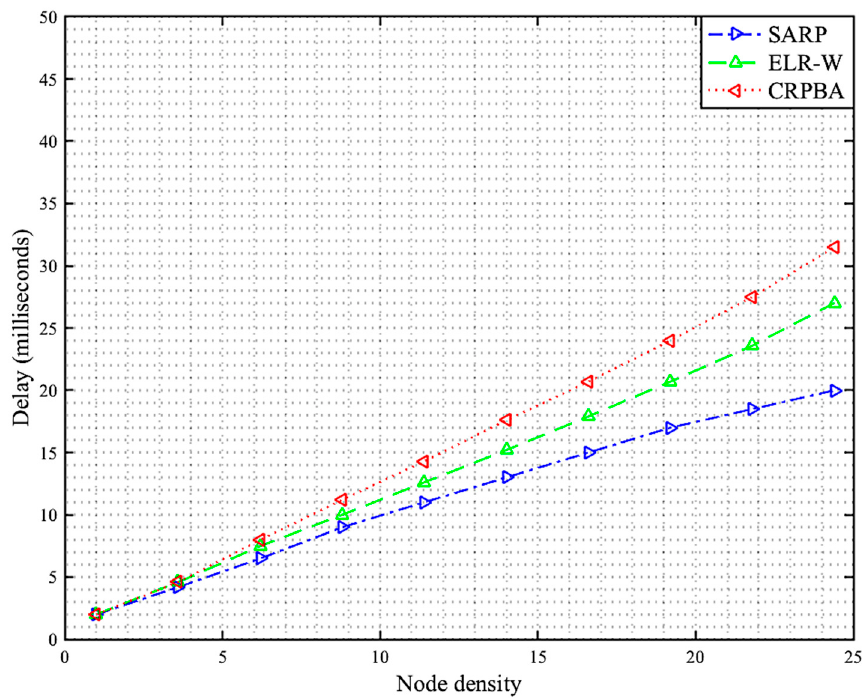
Figure 3. Latency vs node density.